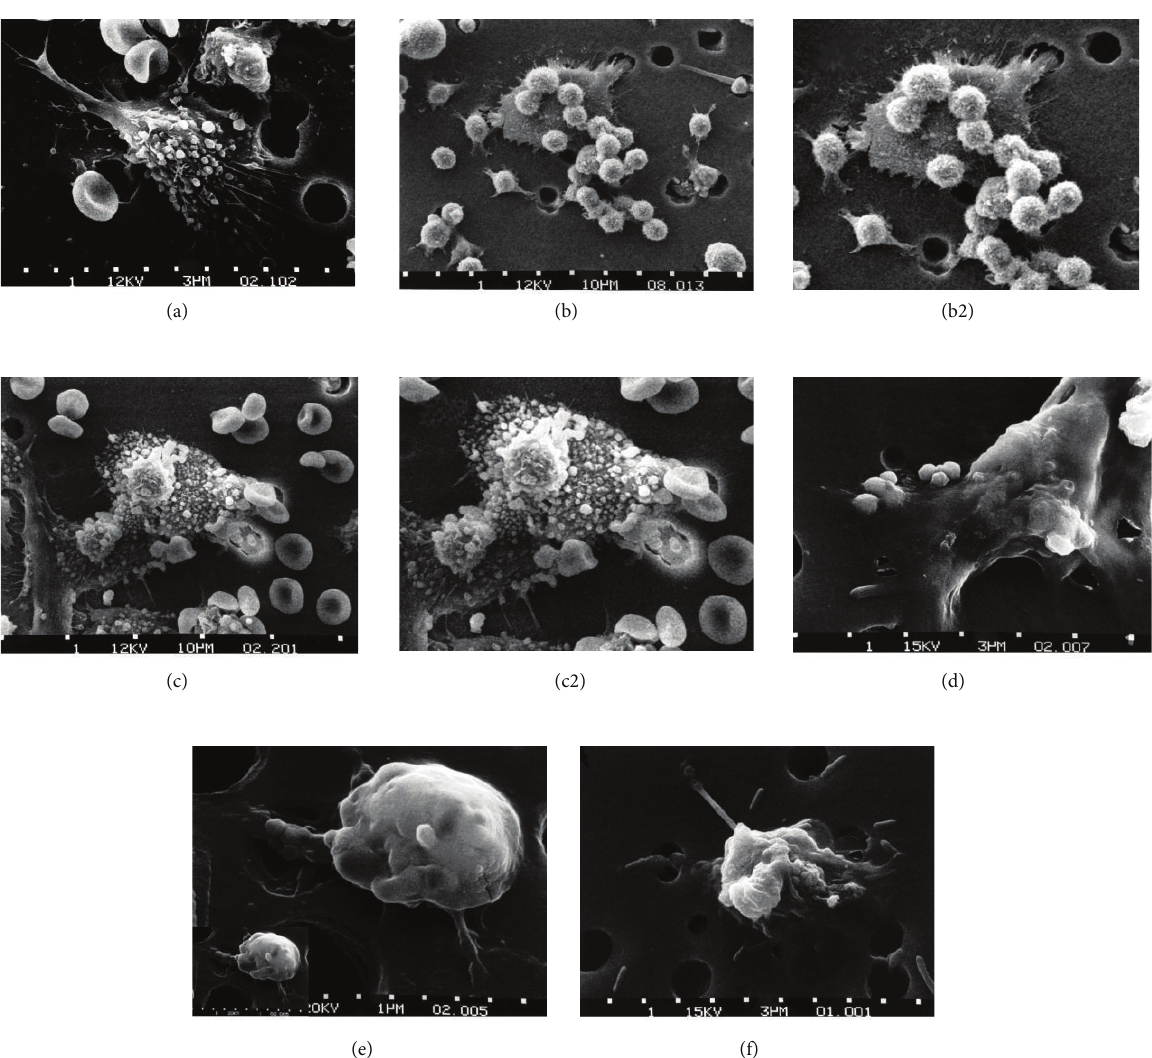
Figure 12: Six-step sequence showing the death of a cancer cell. (a) One cancer cell is migrating through a hole of a matrix-coated membrane from the top to the bottom, simulating natural migration of an invading cancer cell between, and sometimes through, the vascular endothelium. Notice the spikes or pseudopodia that are characteristic of an invading cancer cell. A film coat containing red blood cells, lymphocytes, and macrophages is added to the bottom of the membrane. (b) A group of macrophages identify the cancer cell as foreign matter and start to stick to the cancer cell, which still has its spikes. (b2) enlarged for relative cancer cell size comparisons for approximate equal magnifications between Figures (a), (b2), (c2), (d), (e) inset lower left, and (f). (c) Macrophages begin to fuse with, and inject toxins into, the cancer cell. The cancer cell starts rounding up and loses its spikes. (c2) enlarged for cancer cell size comparisons. (d) As the macrophage cells become smooth, the cancer cell appears lumpy in the last stage before it dies. (e) Lumps covering the cancer cell surface are actually the macrophages fused within the cancer cell with inset at lower left for cancer cell size comparisons showing a great reduction in size. (f) The cancer cell then loses its morphology, shrinks up more, and dies. (With permission from the National Institutes of Health/Department of Health and Human